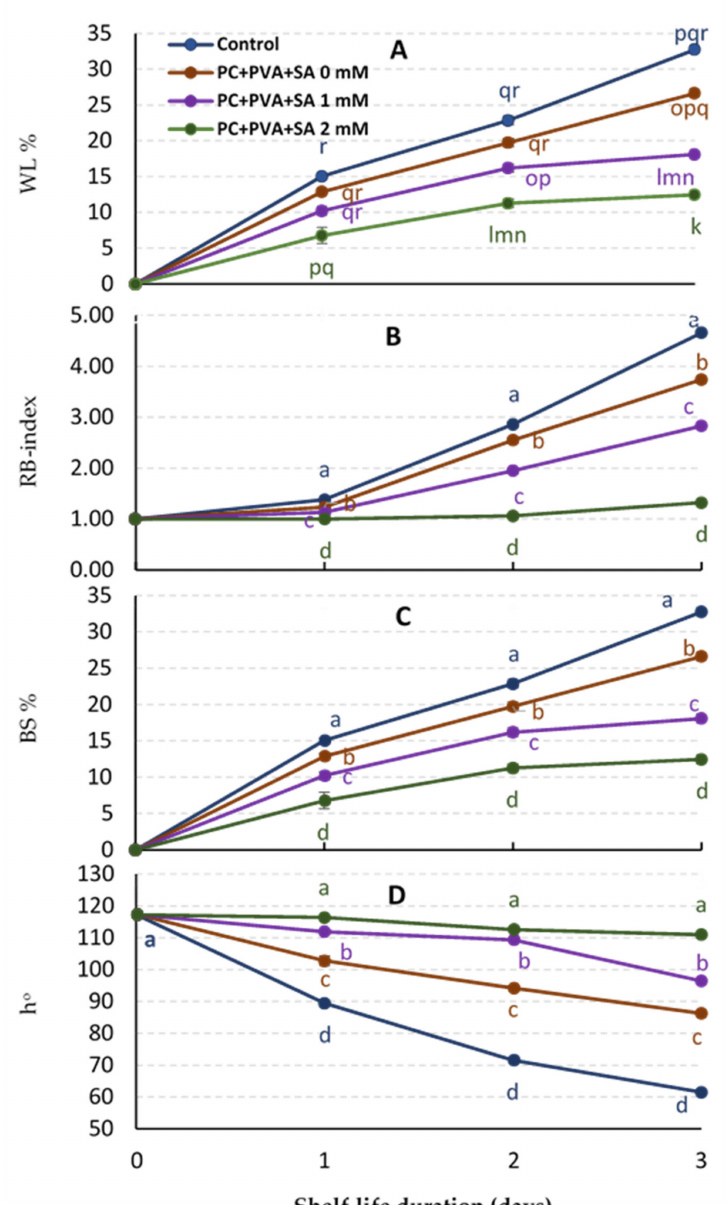
Figure 3. WL (%) ( A ), RB-index ( B ), BS (%) ( C ), and berry h o ( D ) of ‘Crimson seedless’ grapes coated with PE + PVA blending with SA at different concentrations (0, 1, and 2 mmol L − 1 ) and stored at room temperature (26 ± 1 ◦ C and 65 ± 5% RH) for 3 d. Each value represents a mean of three replicates, with error bars representing standard errors ( ± SE), and different letters indicate significant differences at p ≤ 0.05 between treatments. Mean comparisons were performed between all